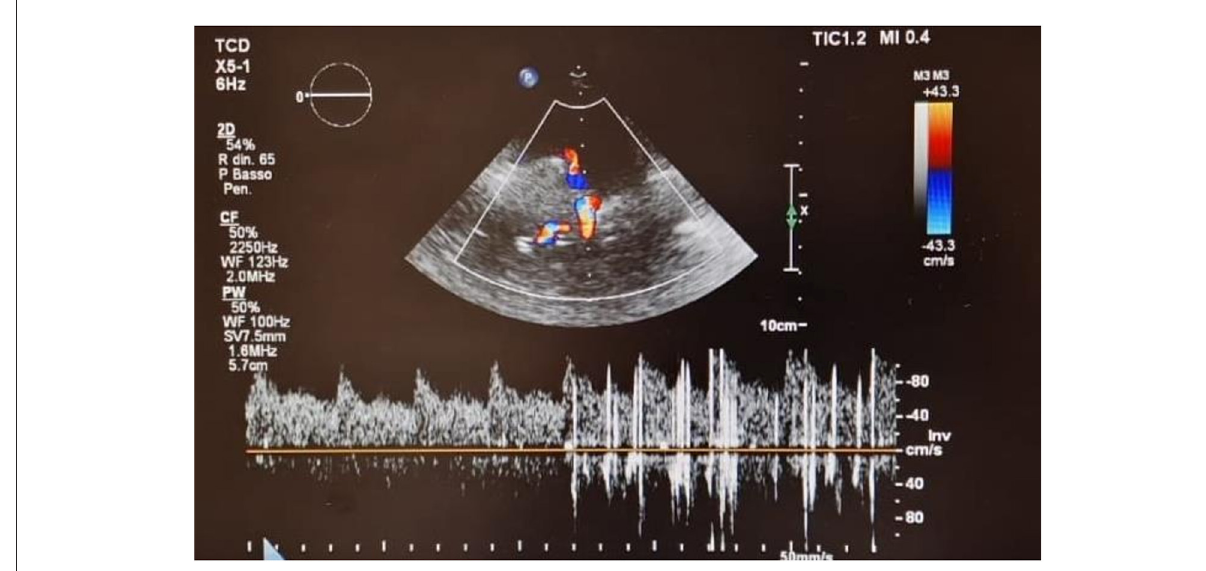
FIGURE3 Contrast Transcranial Doppler in basal conditions showing high-intensity transient signals passing through the middle cerebral artery with a delayed (17s) “shower” pattern.